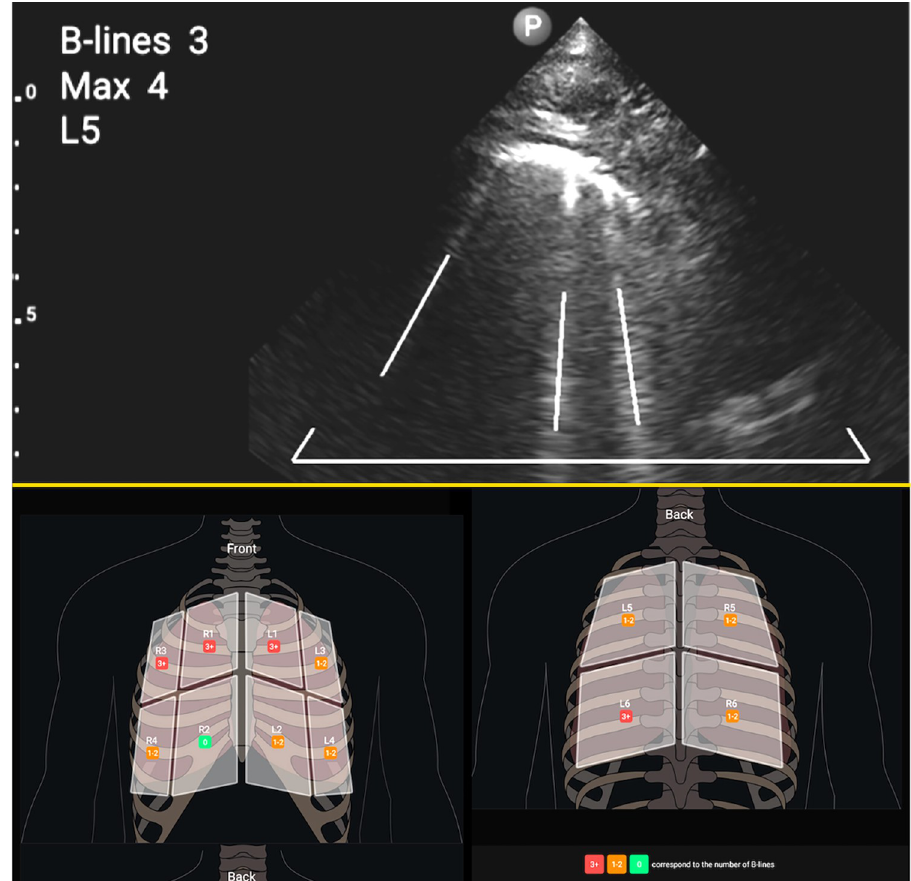
Fig 2. Ultrasound B-lines. B-lines were automatically analyzed using the real-time deep learning-based application, which counted the number of B-lines (indicated by the white lines in the upper panel) in the movie, and recorded the maximum number of B-lines. Three or more B-lines in each zone were considered abnormal (red zone in lower panel). Patients with one or more abnormal zones were considered positive for AI-POCUS.